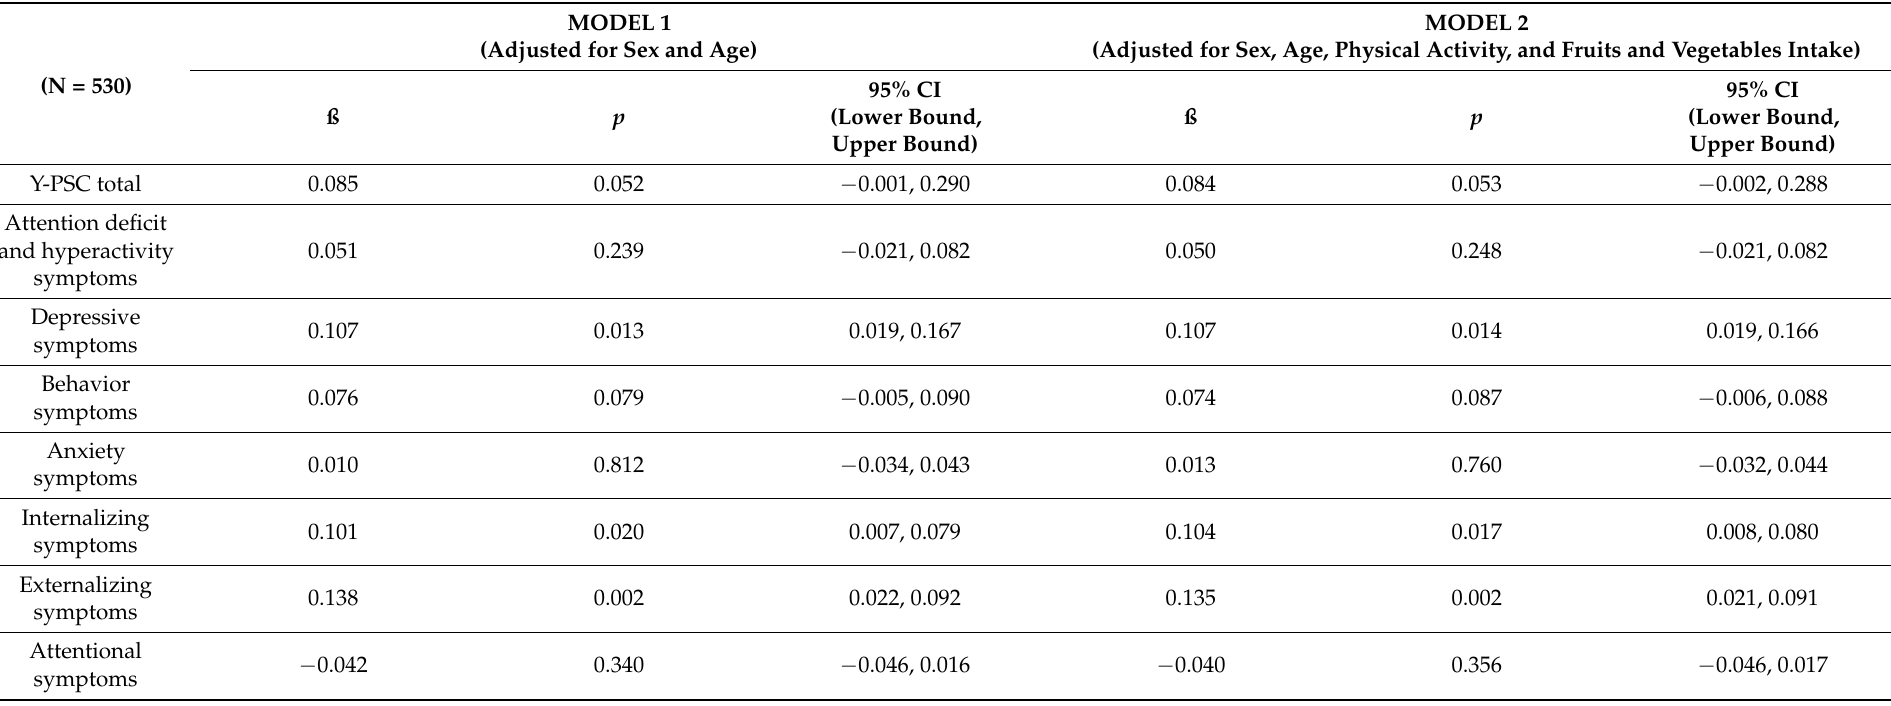
Table 3. Association between total consumption of ultra-processed foods and drinks and psychosocial functioning in all participants and stratifying by